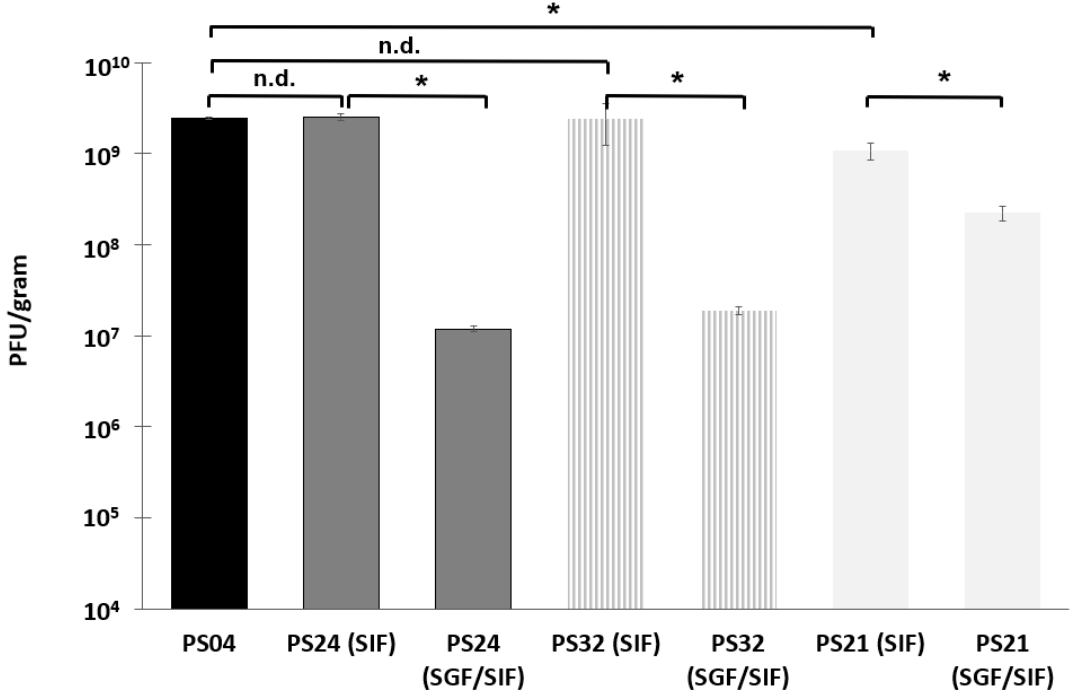
Figure 2. Concentration of encapsulated phage Felix O1 released from spray-dried powders after complete dissolution in SIF (~3 h). Samples labelled SIF were exposed to SIF only without acid exposure, whereas samples labelled simulated gastric fluid (SGF)/SIF were first exposed to simulated gastric fluid (pH 2) for 2 h, subsequently centrifuged to remove the acid supernatant, and then SIF (pH 7) was added to the sample to dissolve the polymer. All formulations were spray-dried at 150 °C inlet temperature corresponding to 82 °C outlet temperature. * Indicates significant difference in means ( p < 0.05) using a two-sample t -test; n.d. means no difference ( p > 0.05). Error bars represent one standard deviation; all measurements were done in triplicate ( n = 3).